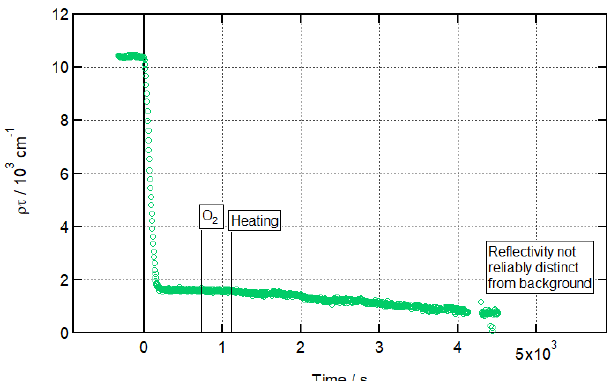
Figure 7. Gradual loss of residue due to increase in tempera- ture. Time evolution plot for ozonolysis of 29µL 1.0gL − 1 d 34 - OA (CHCl 3 spreading solution) on pure subphase by 754 ± 89ppb O 3 introduced at t = 0s at 2 ± 1 ◦ C, with temperature ramping (de- scribed in detail in the text) from t = 1035s; error bars are omitted for visual